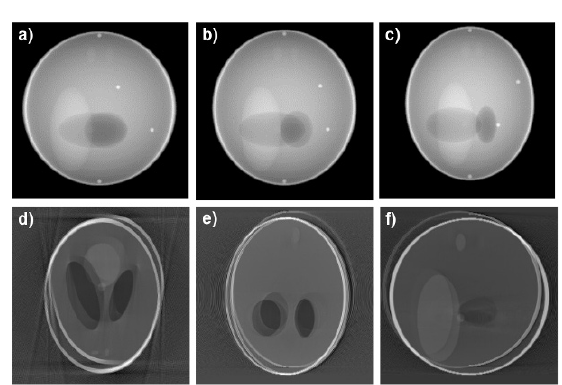
Figure 5. (a–c) projection at 200°, 220° and 240° source position; (d–f) axial, coronal and sagittal slices of the translational motion corrupted reconstructed volume.